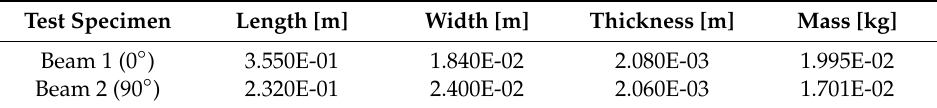
Table 1. Sizes and mass of the two carbon / epoxy test beams.